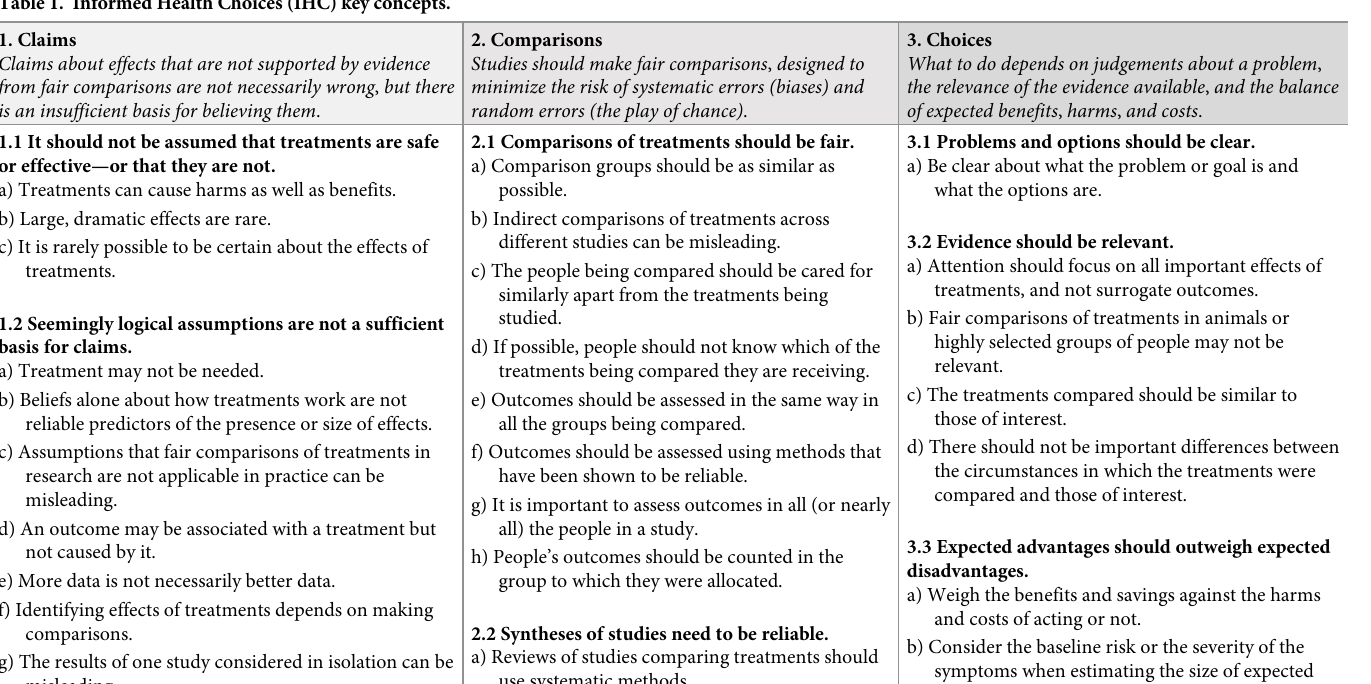
Table 1. Informed Health Choices (IHC) key concepts. 1.